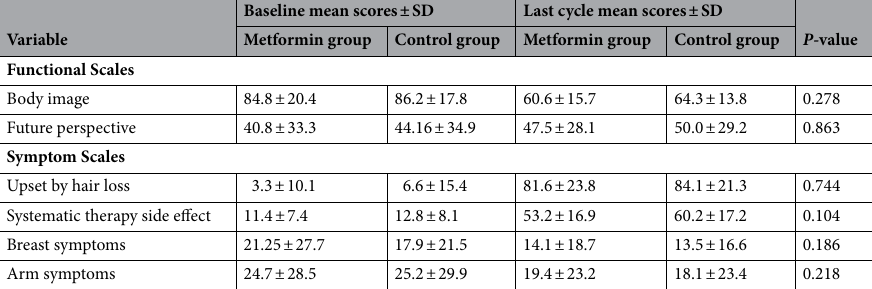
Table 6. Comparison of the mean scores of EORTC QLQ-BR 23 functional and symptoms scales between the metformin group and the control group at baseline and last chemotherapy cycle. EORTC QLQ European Organization for Research and Treatment of cancer quality of life questionnaire, SD standard deviation, P -value: the variance from baseline between the two groups using ANCOVA